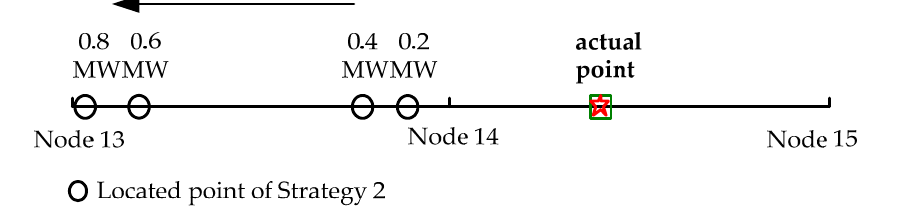
Figure 6. Located points of Strategy 2 with the change of IIDG capacity.